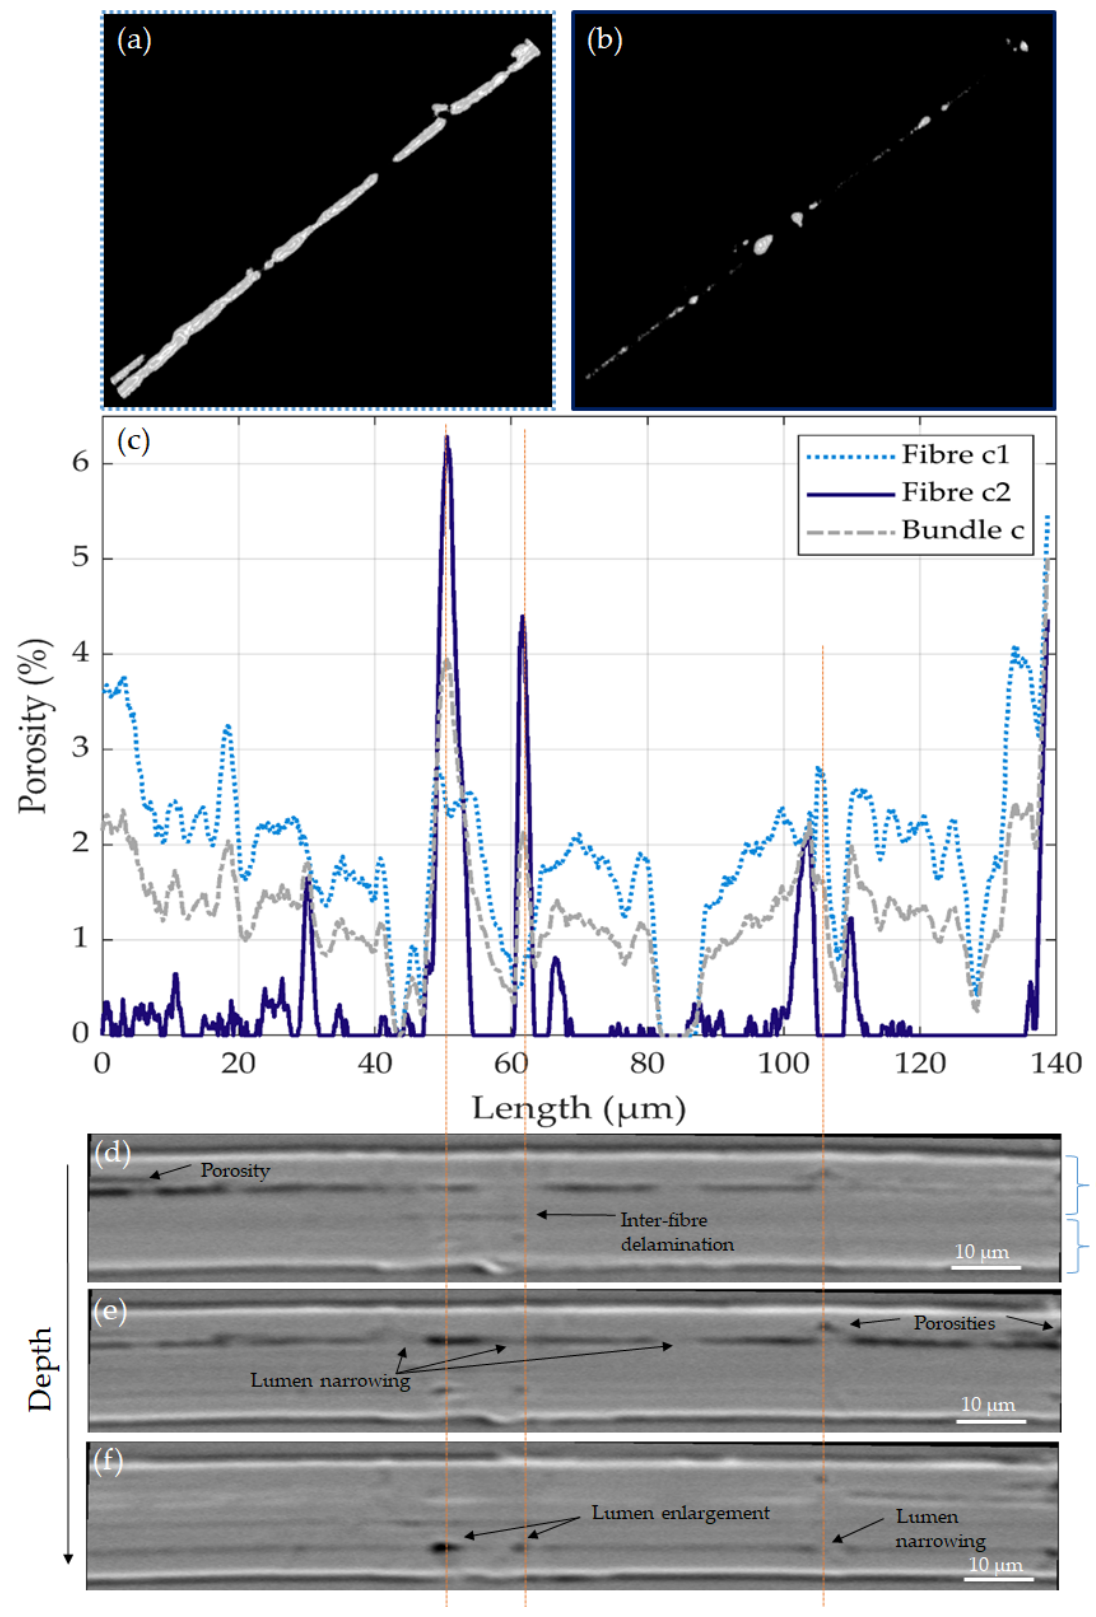
Figure 11. ( a , b ): 3D views of the internal porosity of fibres “c1” and “c2” respectively; ( c ) porosity profile along bundle “c” and the contribution of its two constitutive flax fibres “c1” and “c2”; ( d – f ): longitudinal bundle cross-sections at increasing depths; from µCT data.